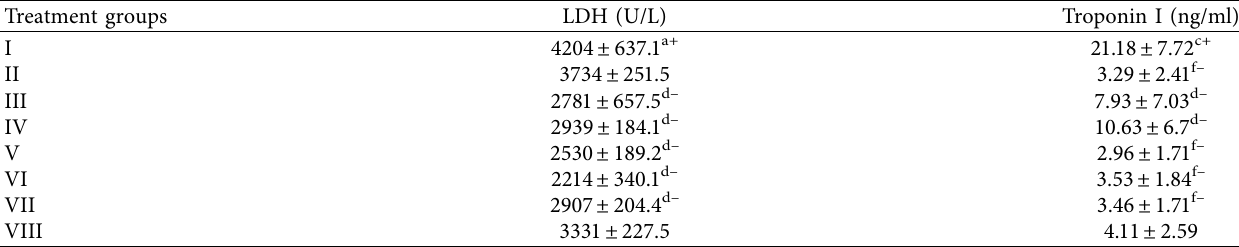
Table 9: Effect of 50–400mg/kg/day of CVE on serum LDH and cardiac troponin I in DOX-intoxicated rats. Treatment groups